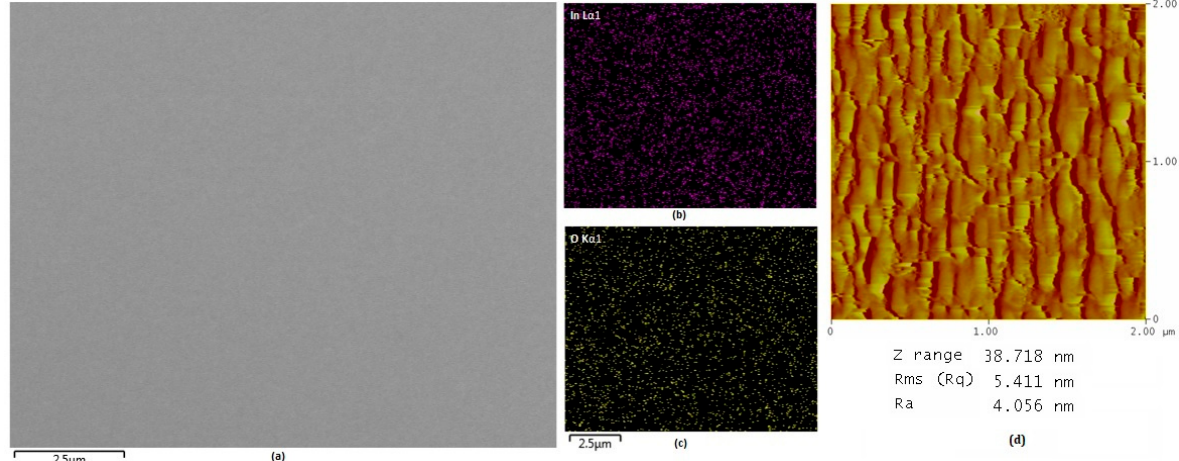
Figure 2. ( a ) The scanning electron microscopy (SEM) micrograph of the ITO surface coated on the glass slide. ( b ) The SEM maps for indium. ( c ) The SEM maps for oxygens showing the uniform distribution of the atoms on the substrate. ( d ) The atomic force microscopy (AFM) image of the ITO thin film showing the surface roughness with the root mean square (RMS) height of ~5 nm and the mean spacing of ~180 nm. Catalysts 2021 , 11 , x FOR PEER